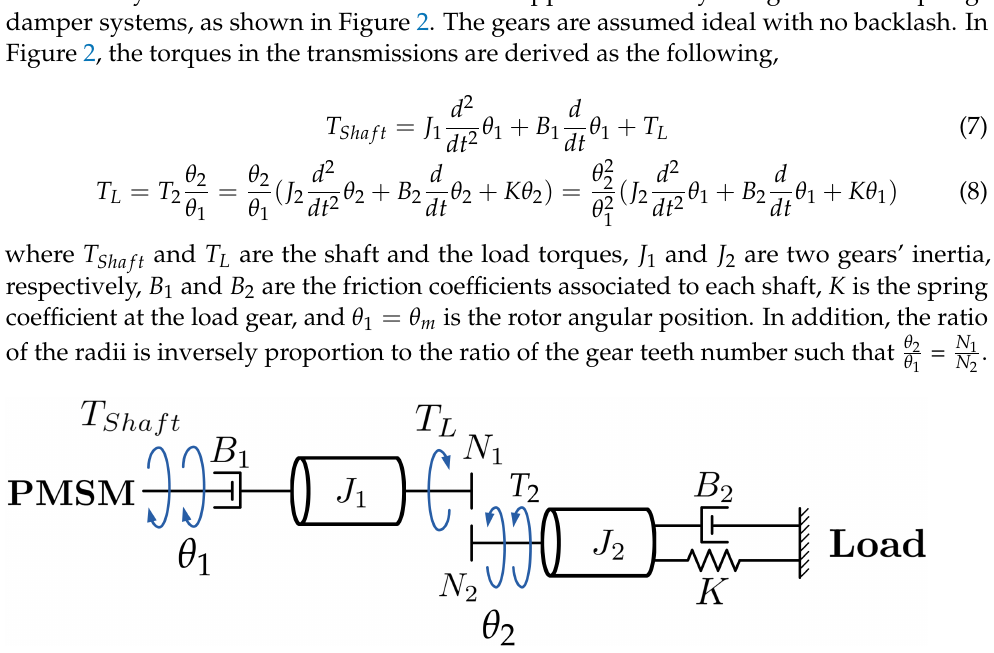
Figure 2. Mass–spring–damper approximation model for